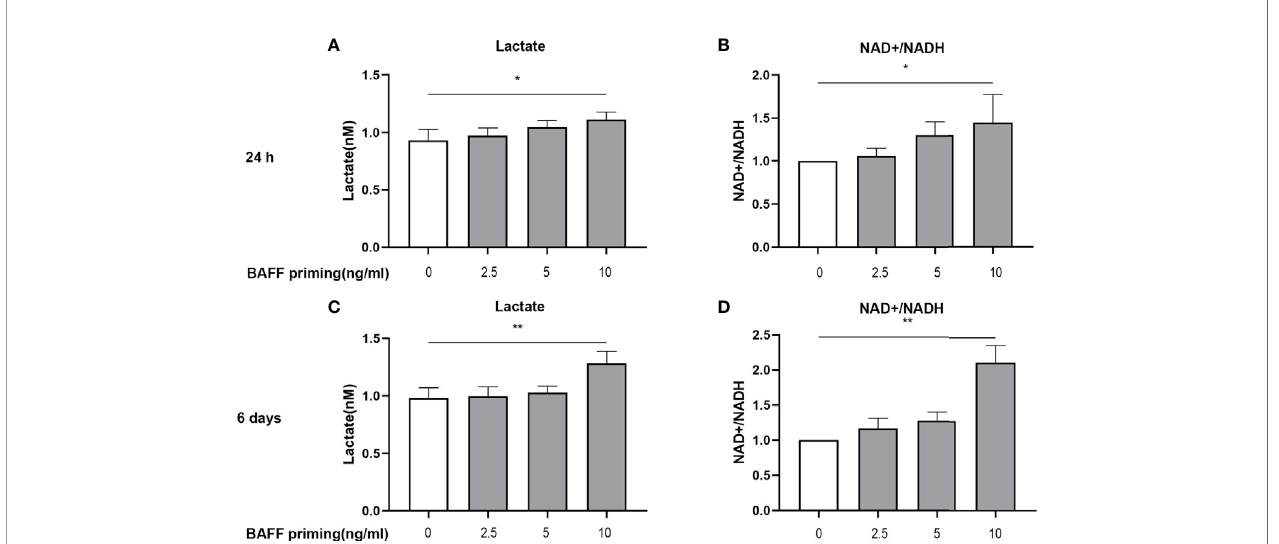
FIGURE 2 | BAFF priming was associated with the induction of glycolysis. BV2 cells were primed with BAFF or vehicle for 24 h and then rested for 5 days. The production of lactate in the supernatants (n = 12) and NAD+/NADH ratio (n = 12) in the whole-cell lysates were assayed 24 h after BAFF priming (A, B) and on day 6 before restimulation (C, D) respectively. Data are means ± SED; Kruskal-Wallis test with Turkey post hoc test; *p < 0.05 and **p < 0.01 compared with CTL.